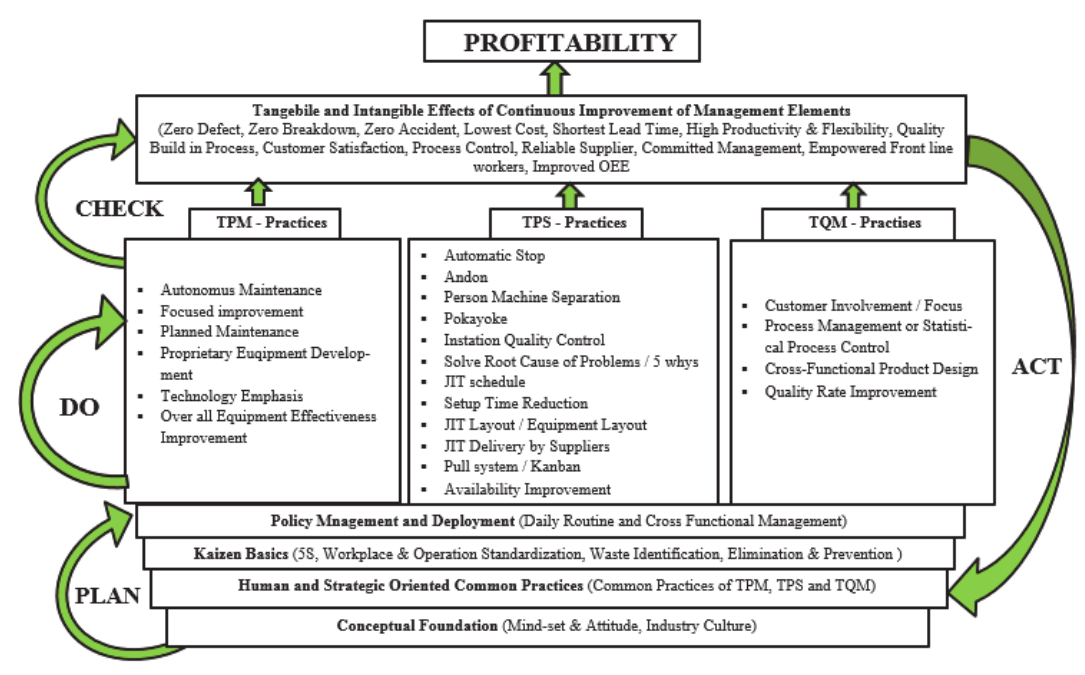
Fig. 2. Cutting-edge TPM, TPS and TQM Integrated